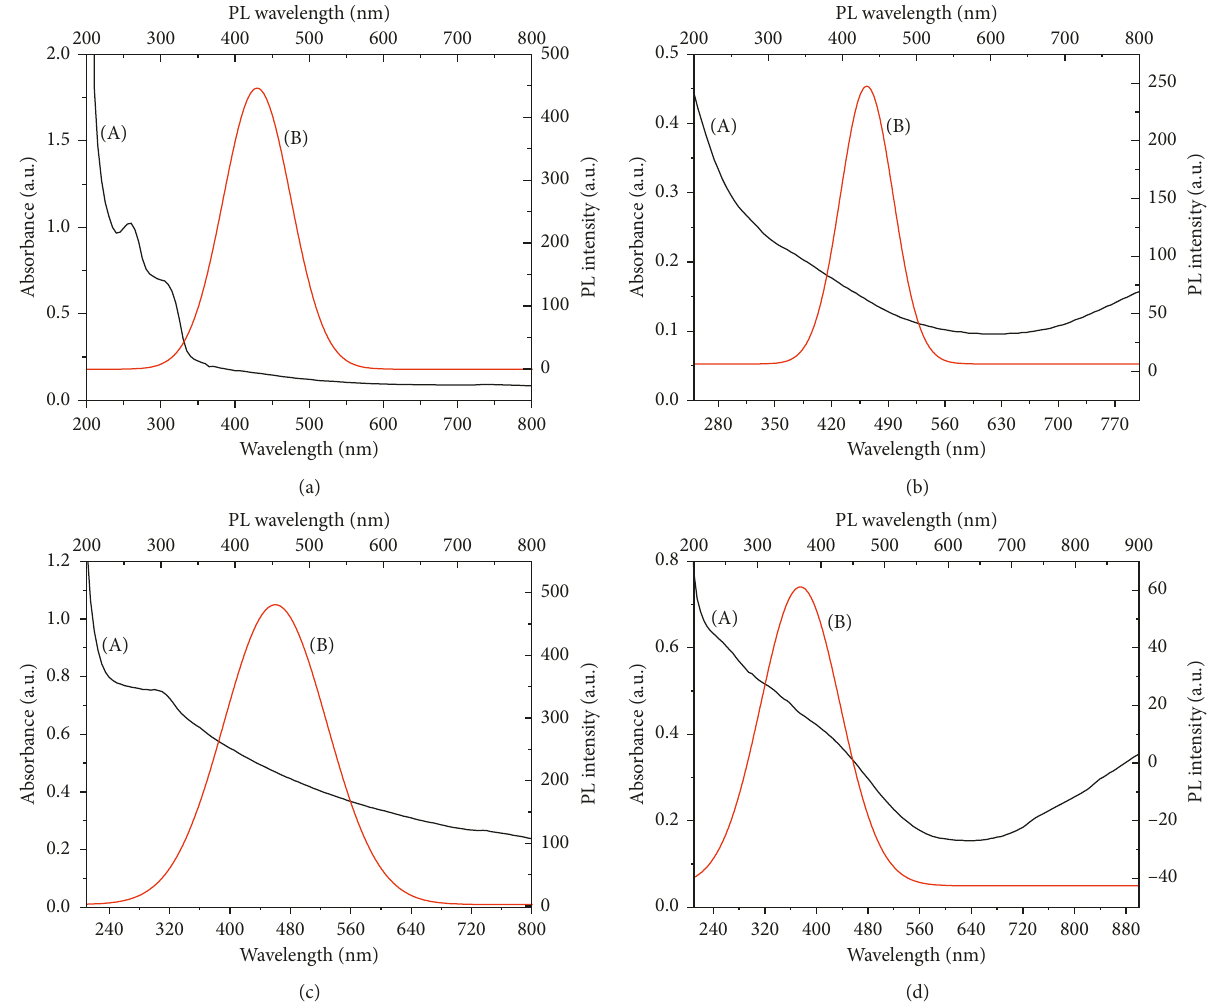
Figure 2: Absorption (A) and emission (B) spectra of (a) L -alanine-capped ZnS nanoparticles, (b) L -alanine-capped CuS nanoparticles, (c) L -aspartic acid-capped ZnS nanoparticles, and (d) L -aspartic acid-capped CuS